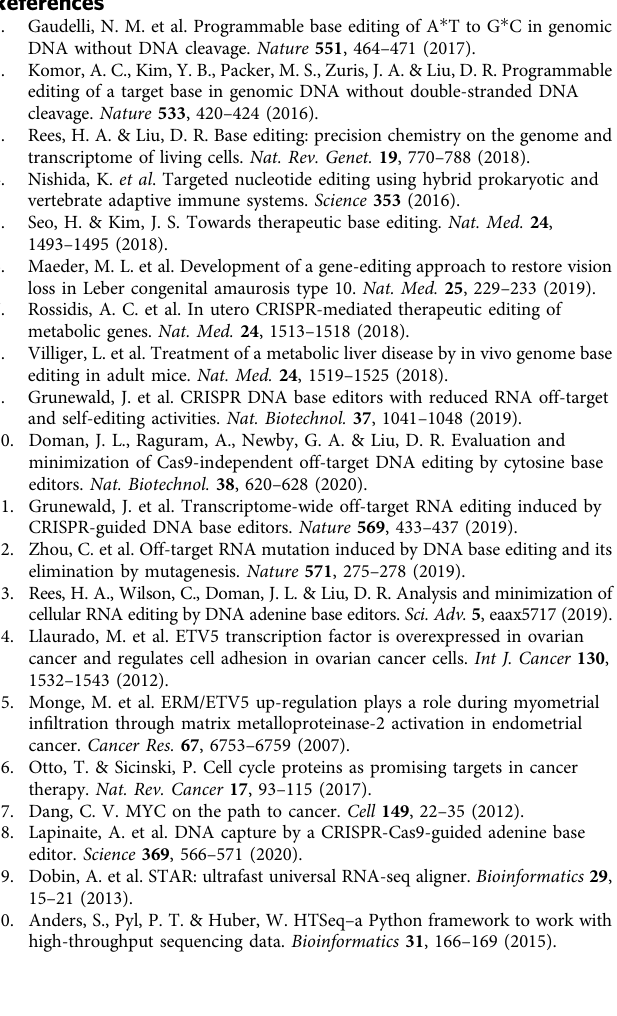
Fig. 3i corresponds to Supplementary Data 11. Fig. 4a – c correspond to Supplementary Data 12. Fig. 5a – c and Supplementary 6a, b correspond to Supplementary Data 13. Fig. 6c corresponds to Supplementary Data